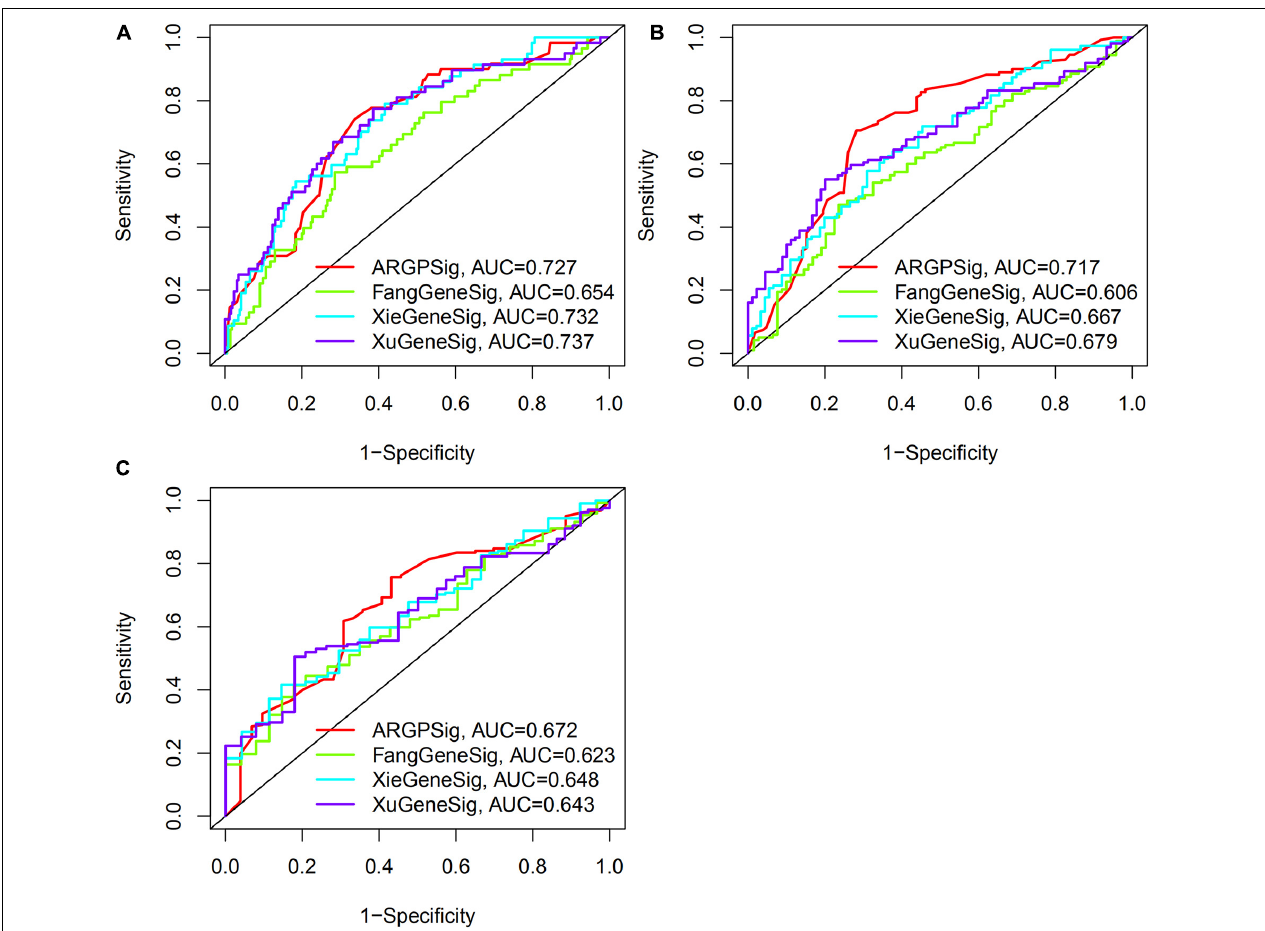
FIGURE 7 | Comparative analysis of the predictive value of ARGP signature with published gene signature. (A–C) The AUC at 1-, 3-, 5-years OS of ARGP signature, Fang gene signature, Xie gene signature, and Xu gene signature,